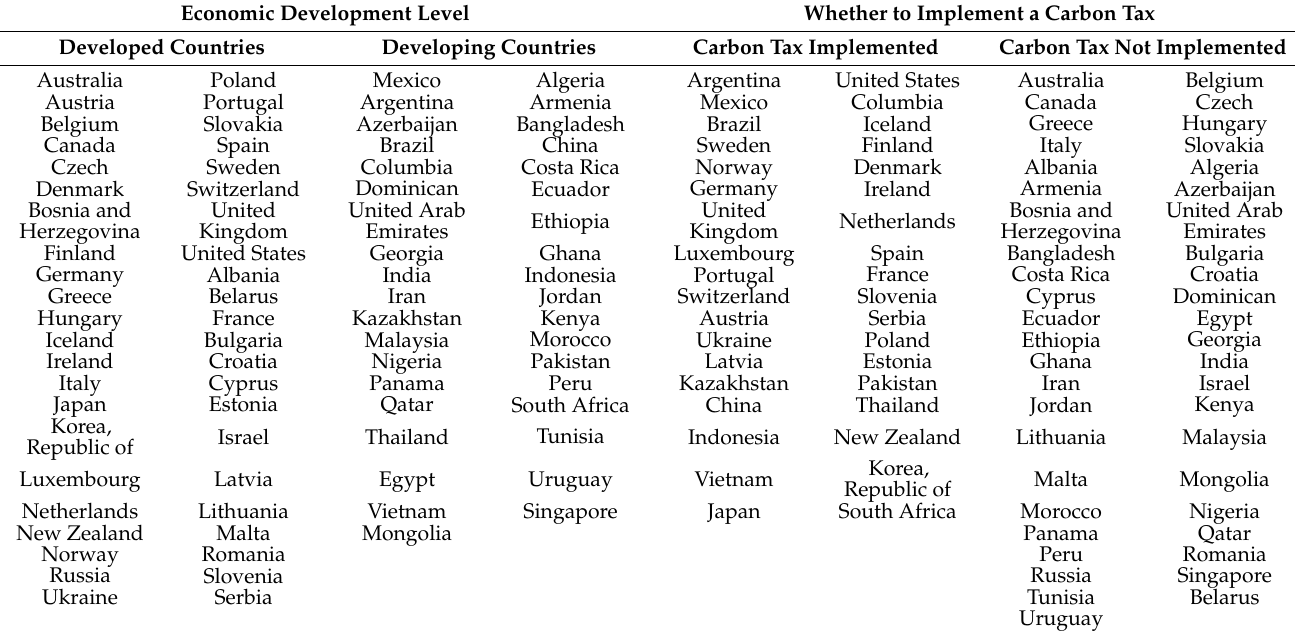
Table 1. List of sample countries in this research.